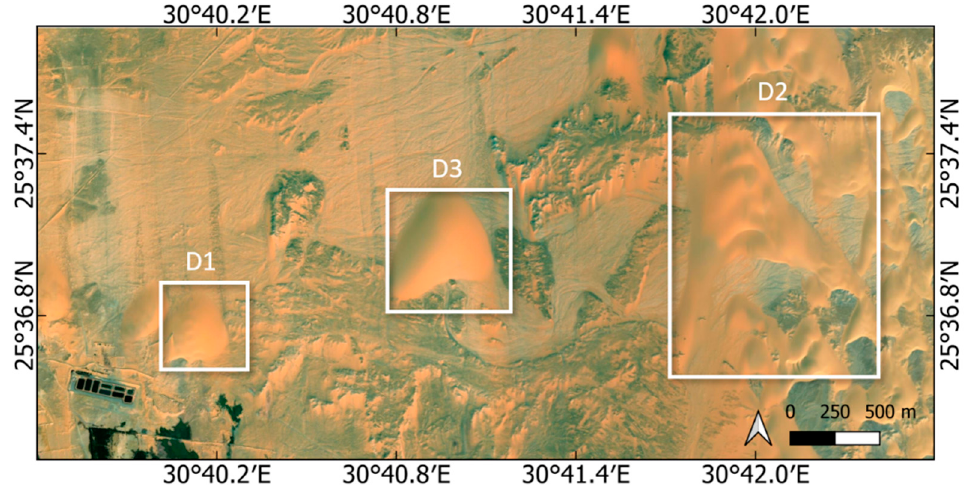
Figure 12. Barchan dunes selected for SAR offset tracking application. Basemap: © Bing Satellite Copyright.